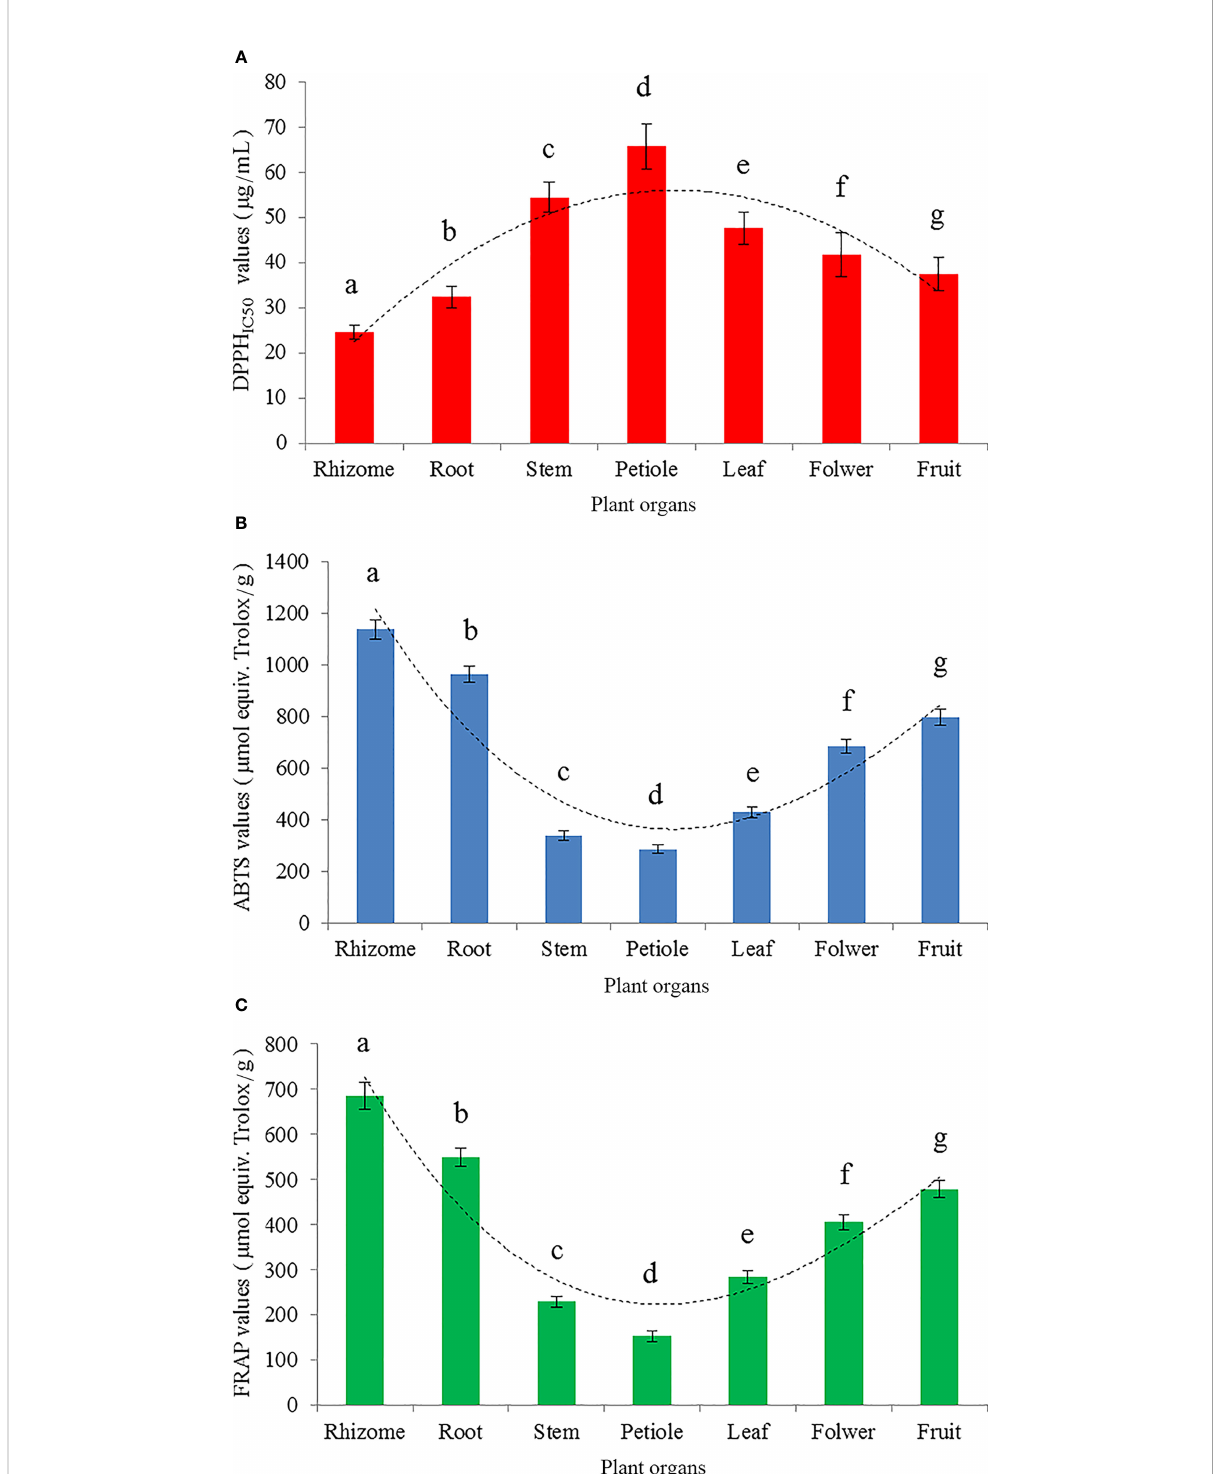
FIGURE 1 Antioxidant activity represented by DPPH IC50 (A) , ABTS (B) and FRAP (C) for different organs of S. hexandrum . DPPH IC50 value is an effective sample concentration at which DPPH radicals were scavenged by 50%. ABTS and FRAP values can re fl ect the results of ABTS radical cation scavenging assay and ferric reducing power assay, respectively. ABTS and FRAP values are both expressed as micromoles of trolox equivalent per gram. All data is presented as mean ± SD (n=3). Different lowercase letters indicate the signi fi cant difference by ANOVA with Tukey ’ s multiple range test